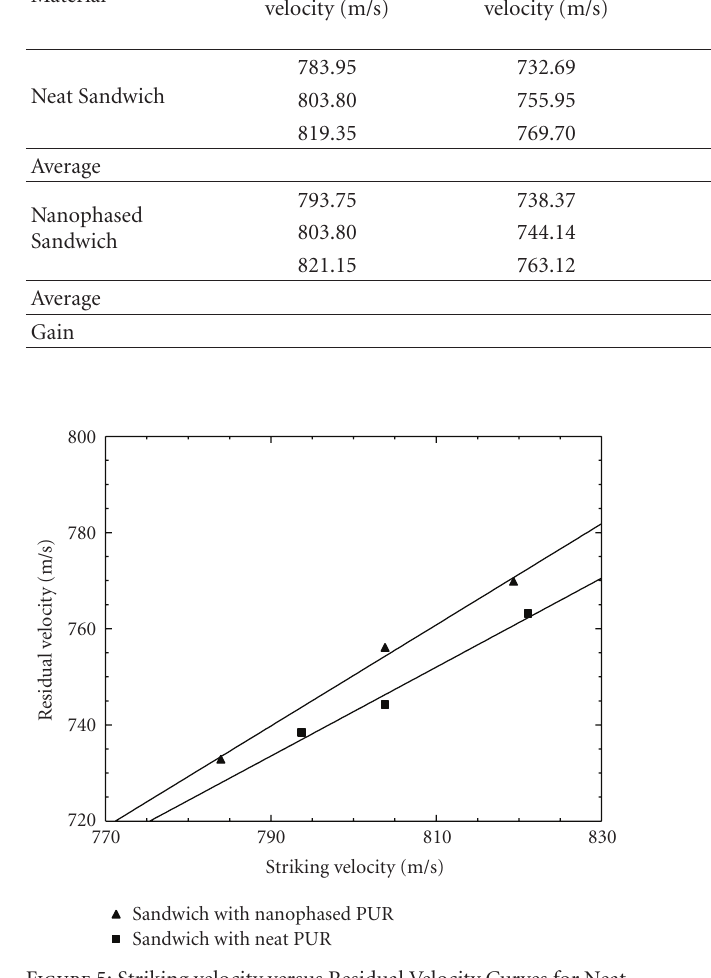
Figure 5: Striking velocity versus Residual Velocity Curves for Neat and Nanophased Sandwiches.